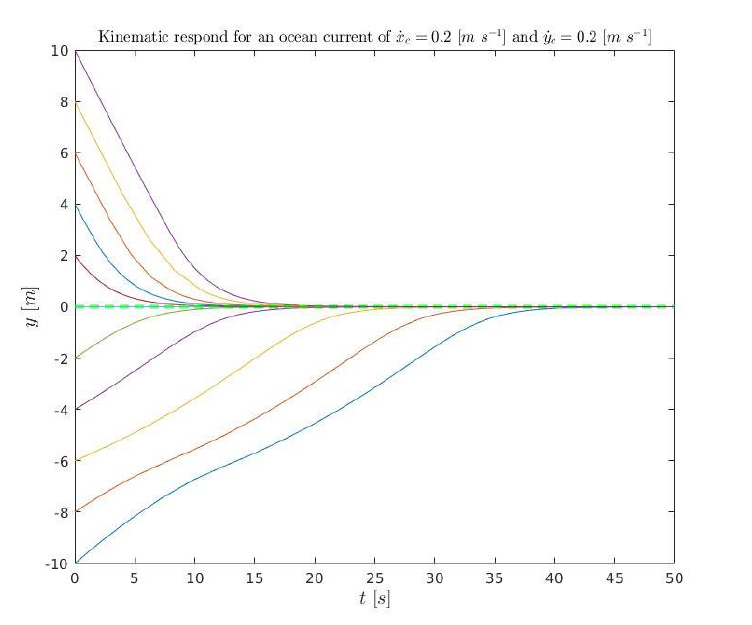
Figure 16. Kinematic simulation for the conditions (36) relative to time. The colored lines represent the different simulations and the green discontinuous line the acceptance tolerance.